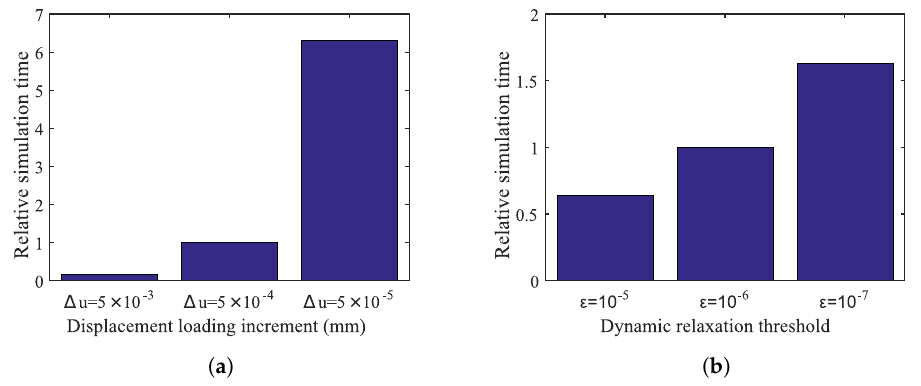
Figure 11. The effect of ( a ) the displacement loading increment and ( b ) the dynamic relaxation threshold on the simulation time.